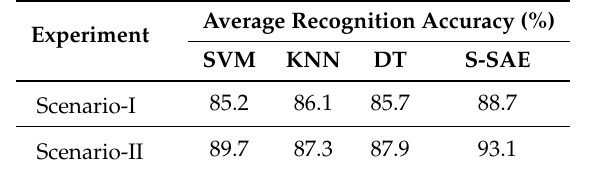
Table 4. State-of-art classification performance.